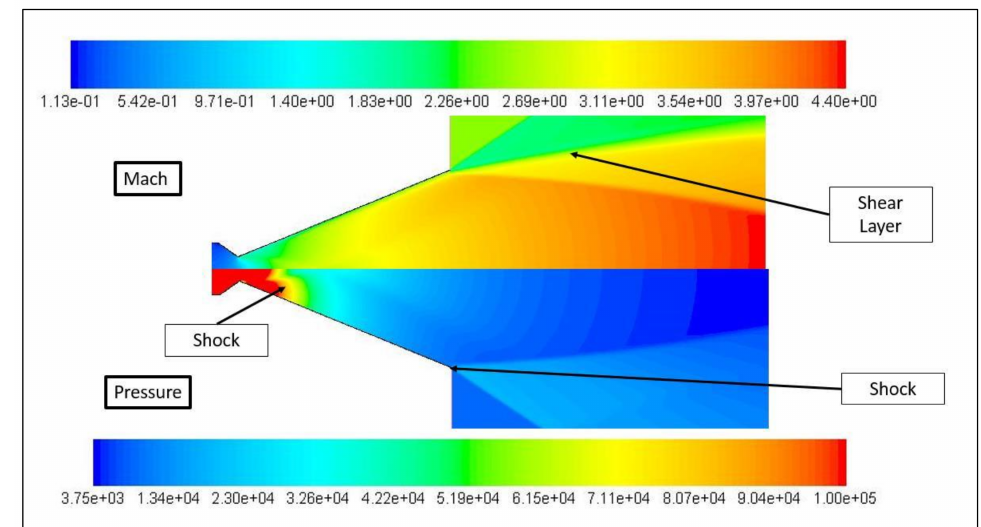
Figure 16. ( Top ) Pressure contour and ( Bottom ) Mach contour thrust = 1.47 × 10 6 N, Nozzle Pressure Ratio ( NPR ) ≈ 100, H1 = 3.8, V1 = 1.8.